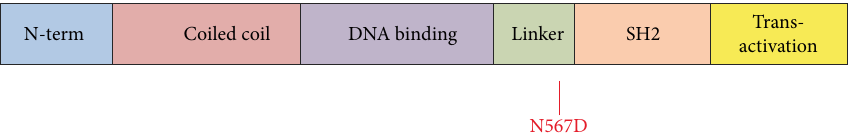
Figure 1: Schematic diagram of STAT3 protein structure showing the position of the N567D mutation identified from a patient with Hyper IgE syndrome.